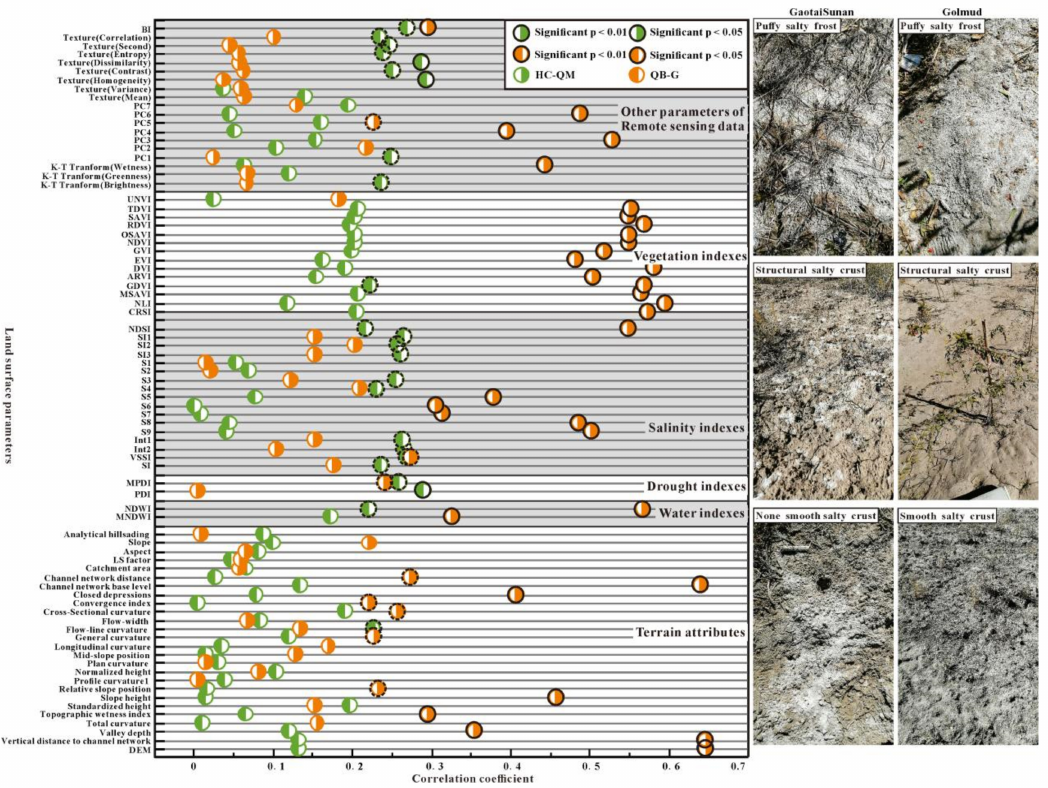
Figure 7. The absolute value of Pearson correlation coefficients between the land surface parameters and soil EC, and the field photos of HC–GM and